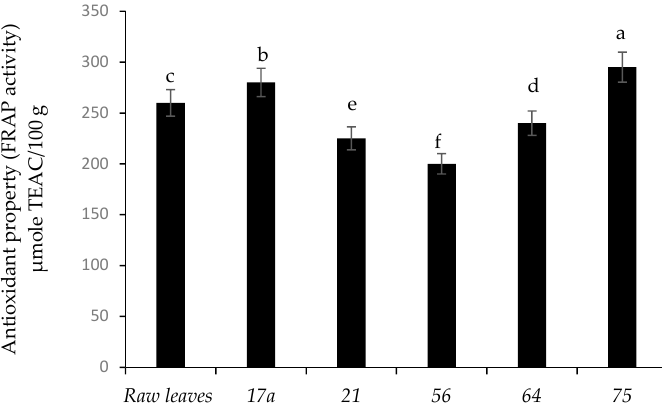
Figure 5. Influence of lactic acid fermentation of Lactobacillus strains on antioxidant activity (FRAP activity) of African nightshade leaves ( Solanum retroflexum ).